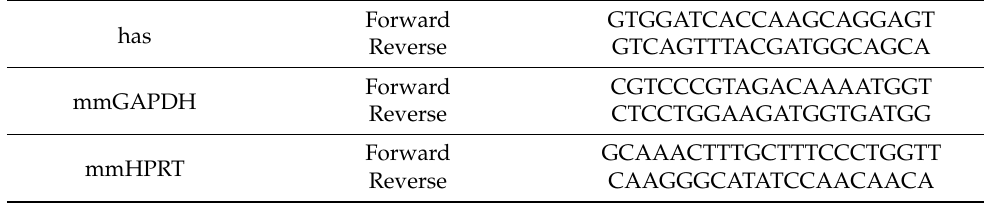
Table 3. Primer sequences for mouse